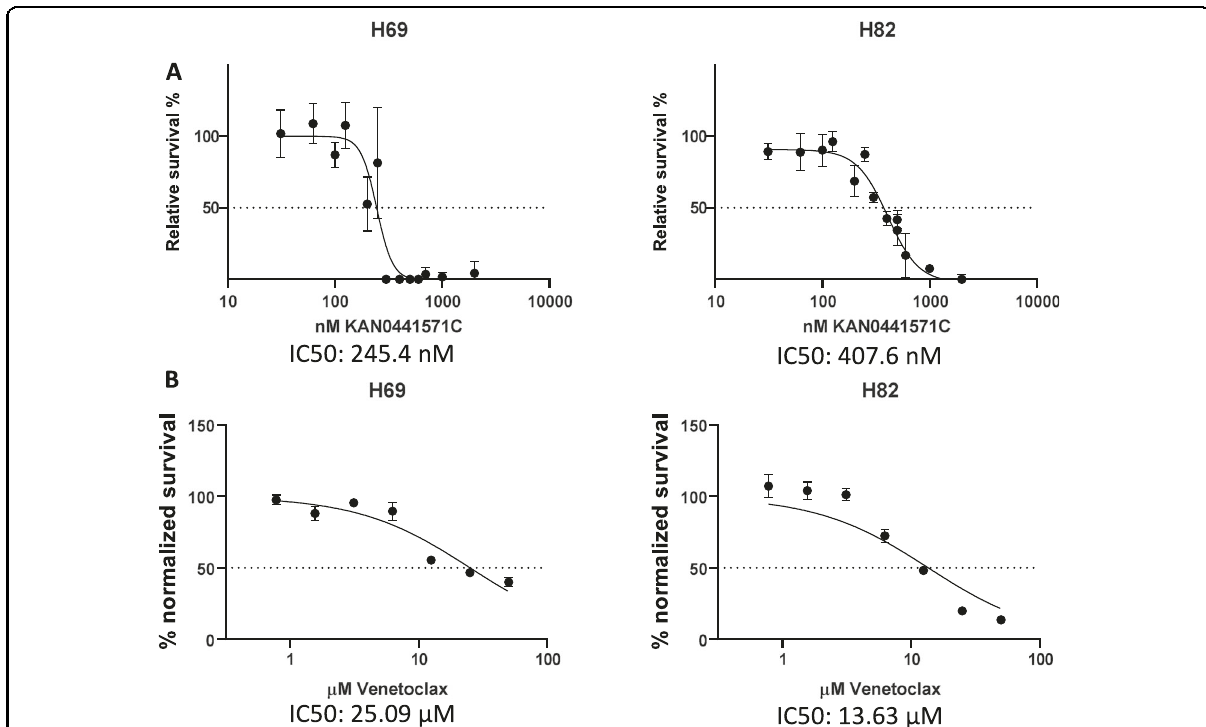
Fig. 3 Dose – response curves of the ROR1 inhibitor KAN0441571C and BCL2 inhibitor venetoclax in representative cell lines H69 and H82 via alamarBlue Cell Viability Reagent. A KAN0441571C dose – response curves and relative IC50 are aggregated results from 2 experiments. B Venetoclax dose – response curves and